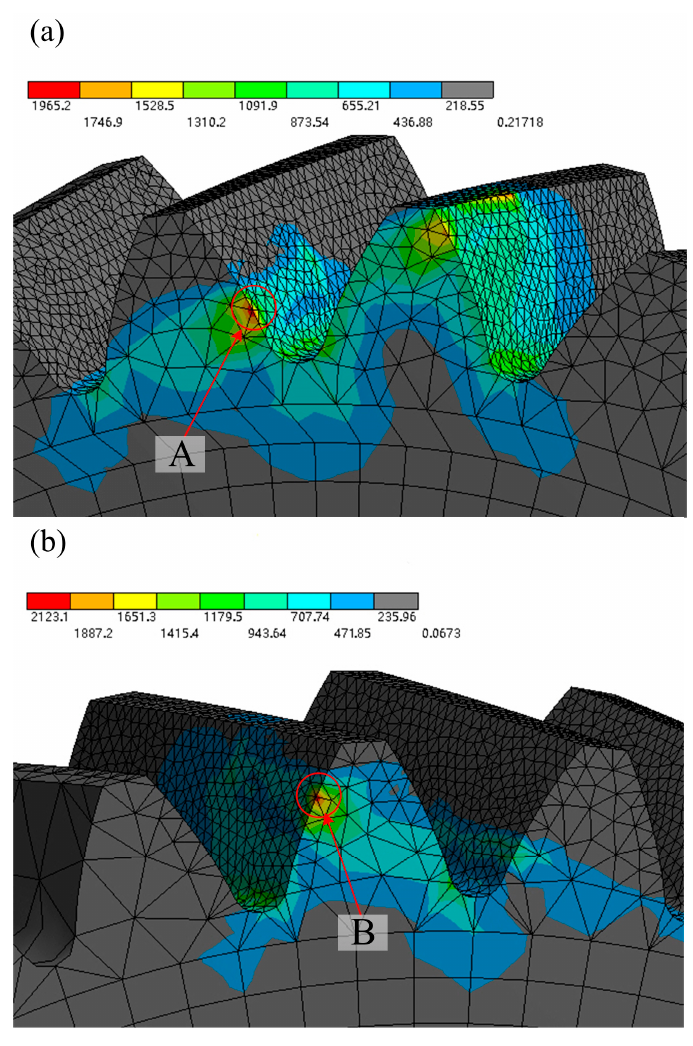
Figure 5. Finite element stress nephograms: ( a ) driving gear; ( b ) driven gear.